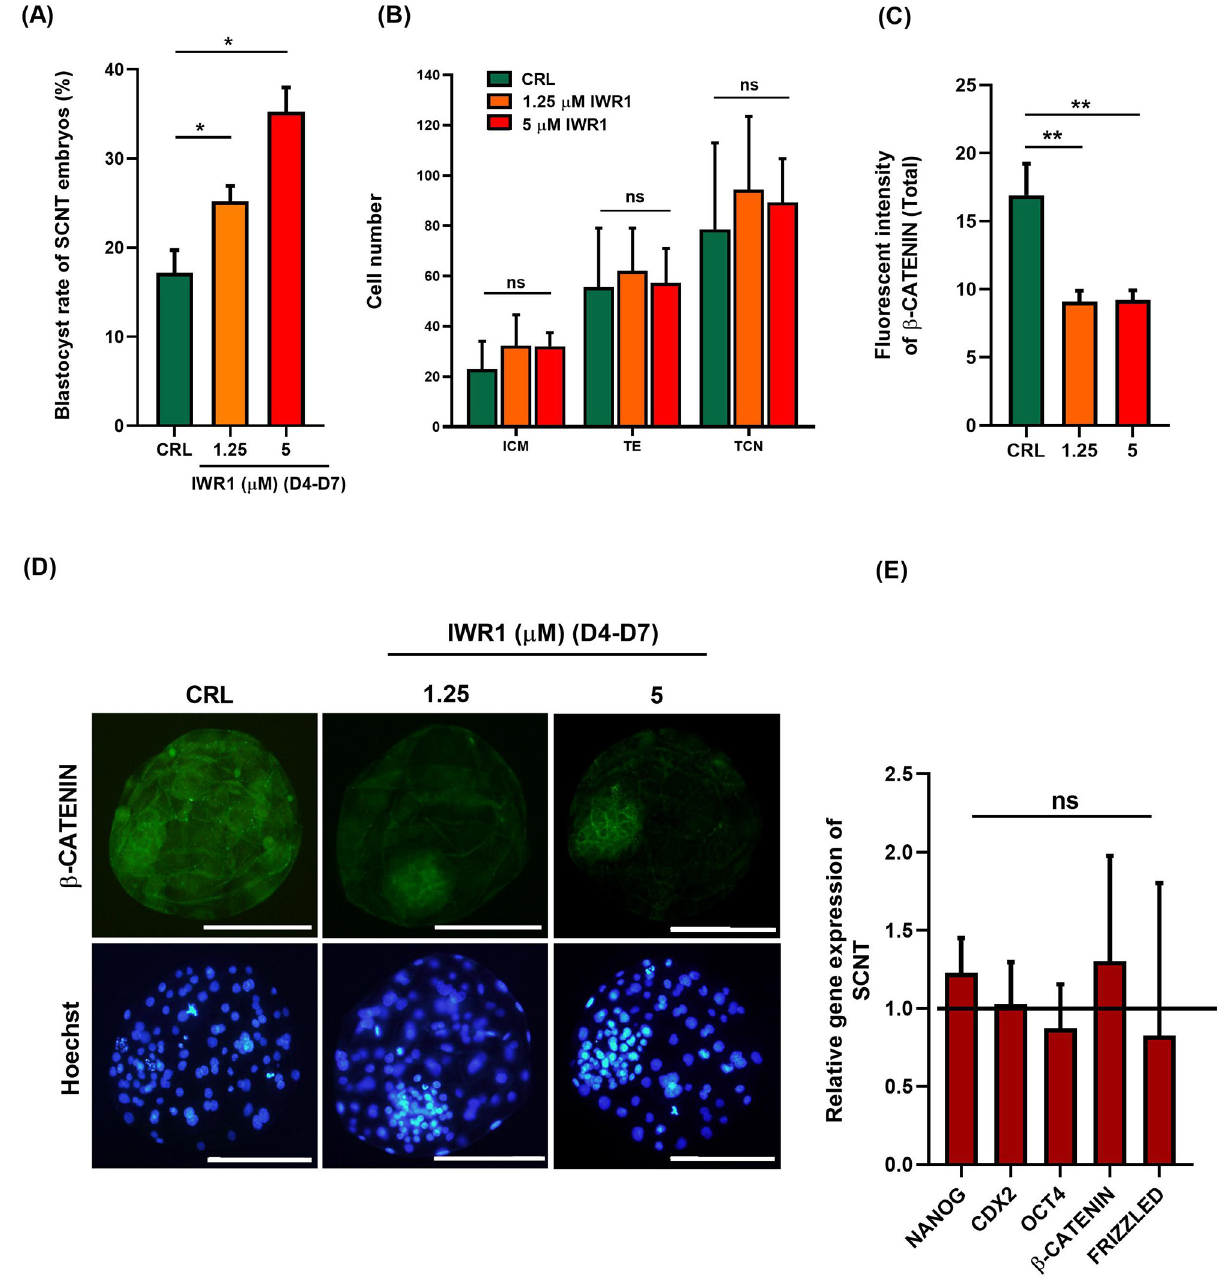
Fig 4. (A) The effect of 1.25 and 5 μ M IWR1 during in vitro culture (IVC) from D4 to D7 in goat SCNT embryos on blastocyst rate (/cleaved embryos). (B) The effect of IWR1 treatment on blastomere allocation of SCNT treated embryos. (C) The effect of IWR1 treatment during D4-D7 on the fluorescent intensity of β -CATENIN in SCNT embryos. (D) Representative immunofluorescence images of β -CATENIN in SCNT embryos following treatment with IWR1 during D4-D7. (E) The effect of 5 μ M IWR1 during D4-D7 in goat SCNT embryos on the relative expression of NANOG , CDX2 , OCT4 and β -CATENIN . Mean ± S.E.M. values are from at least three independent experiments ( * P < 0.05 and ns P > 0.05). Scale bars represent 200 μ m.